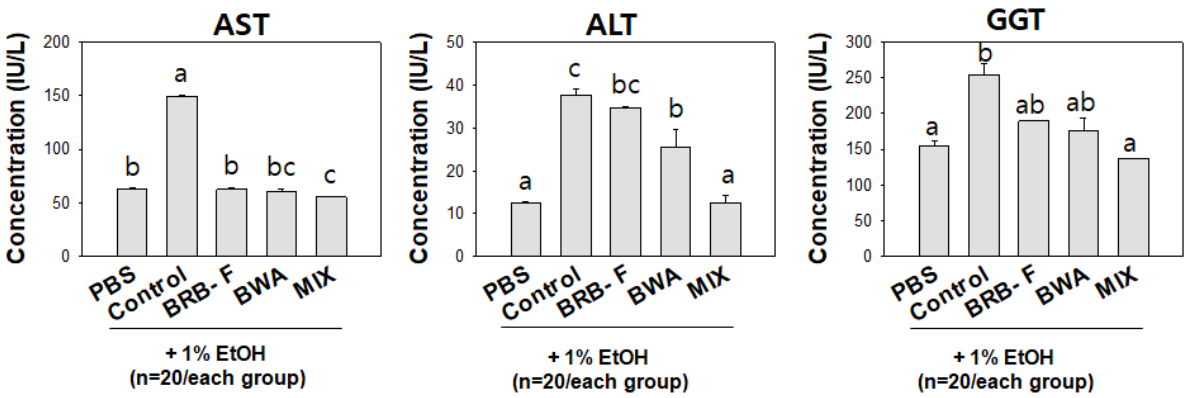
Figure 5. Effect of BRB-F, BWA, and MIX in ethanol-fed zebrafish (n = 20) for 10 days on plasma biomarkers to evaluate the liver function. Data are mean ± SEM; a,b,c mean values with different superscript letters are significantly different among the groups ( p < 0.05). PBS, zebrafish exposed to 1% PBS; EtOH, zebrafish exposed to 1% ethanol; BRB-F, EtOH + 10% black rice bran (wt/wt); BWA, EtOH + 10% beeswax alcohol (wt/wt); MIX, EtOH + 10% mixture of BWA and BRB-F(1:6, w / w ); AST